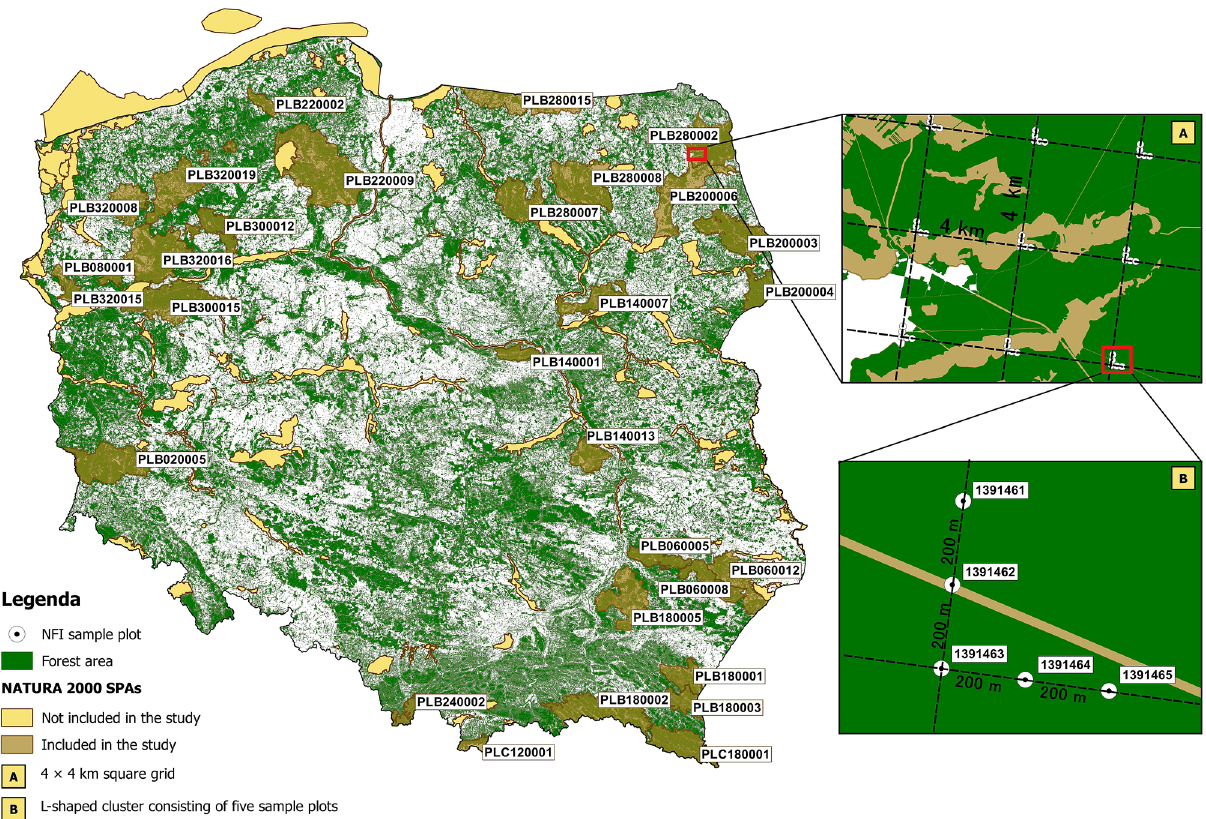
Figure 1. Special protection areas for birds included in the study and the arrangement of clusters of sample plots within the NFI grid (The map was generated based on data from the GDOS 45 and BDL 46 websites. The spatial data was then integrated in the Qgis 3.10 47